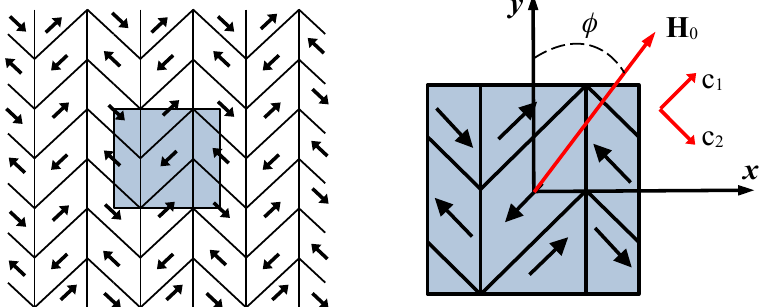
Figure 3. The structure of the twinned variant of martensite (on the left ) and the computational domain in this crystal (on the right